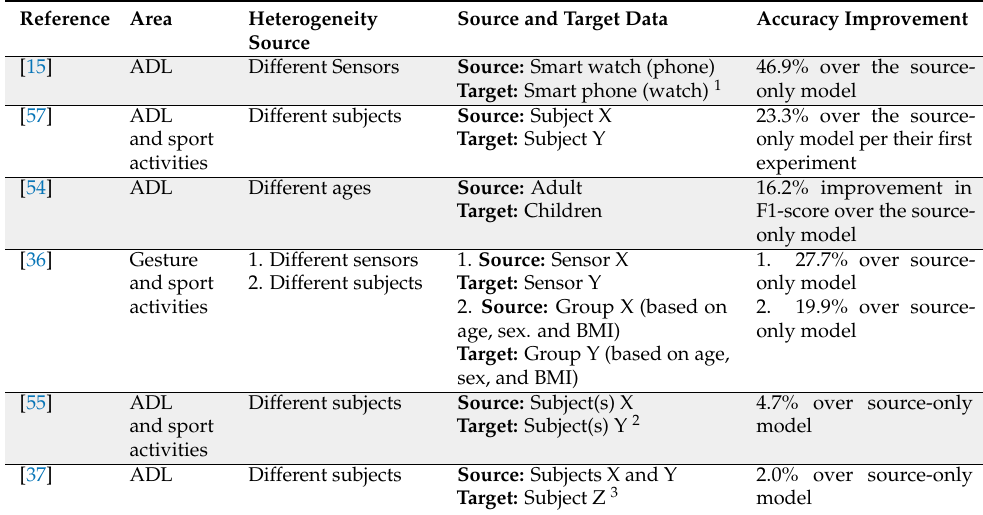
Table 1. A summary of human activity recognition studies using domain